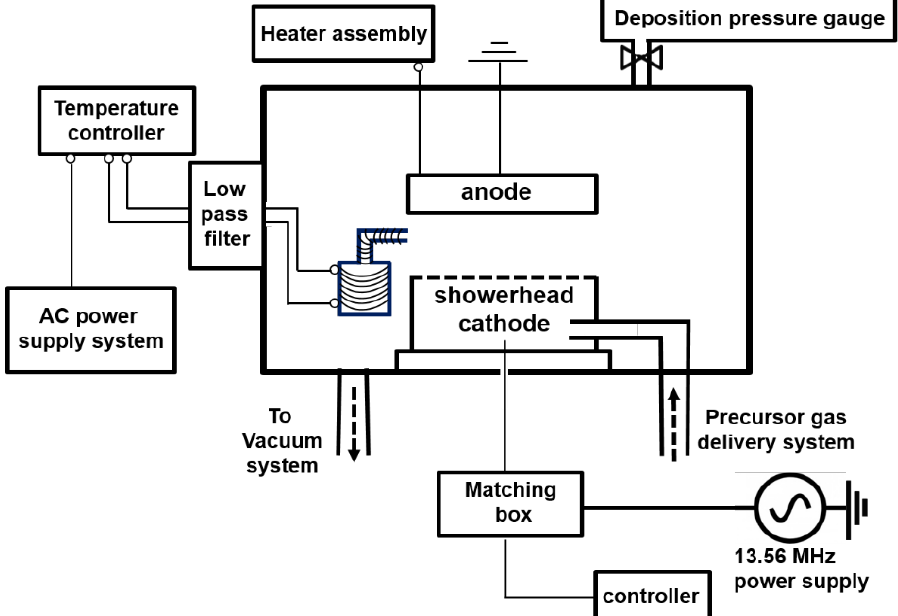
Figure 5. Schematic diagram of the RF-PEMOCVD system used for the preparation of a-C:D(Er)